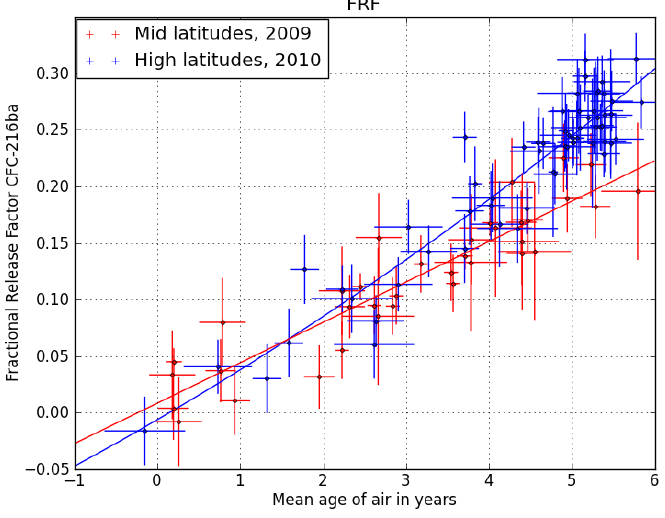
Figure 1. Correlation of fractional release factors of CFC-216ba with mean ages of air (as derived from measurements of SF ) and their respective 1 σ uncertainties. The data 6 originate from stratospheric aircraft campaigns at mid-latitudes in late 2009 (red) and high latitudes in early 2010 (blue).